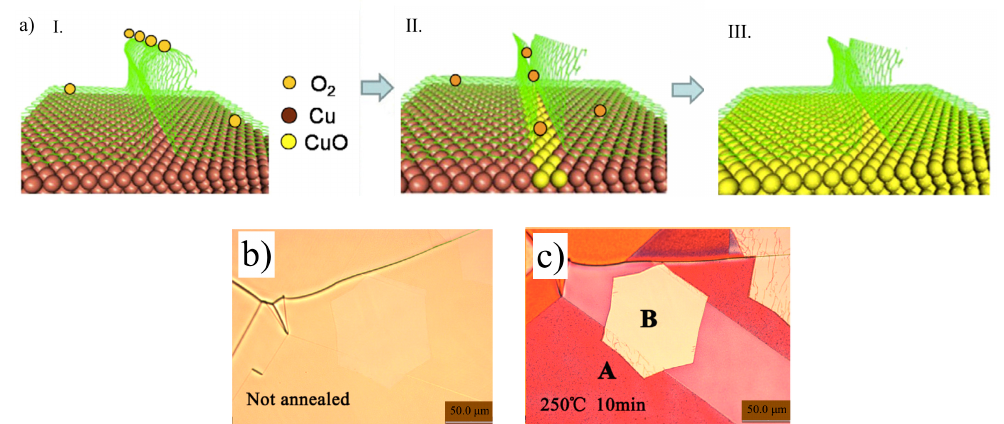
Figure 11. ( a ) Mechanism of oxidation along wrinkles: ( I ) epoxy chain formation, ( II ) subsequent etching, and ( III ) oxidizing agent permeation through narrow slits; ( b ) and ( c ) Optical image of graphene-coated Cu foil before and after annealing in air (10 min at 250 °C), respectively. Oxidation along wrinkles is dependent on the substrate crystal structure. Oxidation lines are not seen in crystal facet B due to an absence of wrinkles. Adapted and reprinted with permission from ref. [150]. Copyright 2014 Elsevier.